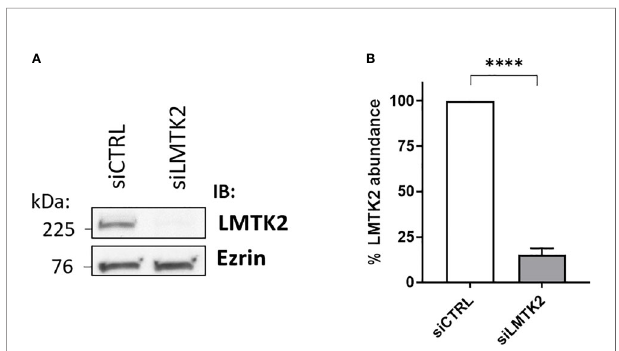
FIGURE 1 | Western blot experiments demonstrating ef fi cacy of the LMTK2 KD by siRNA. Representative blots (A) and summary of experiments (B) demonstrating that siLMTK2 decreased the LMTK2 protein abundance by 85%. CFBE41o- cells cultured in plastic dishes were transfected with siRNA against human LMTK2 (siLMTK2) or siRNA negative control (siCTRL). Ezrin was used as a loading control. ****p < 0.0001 versus siCTRL. 6 experiments/ group. Error bars,